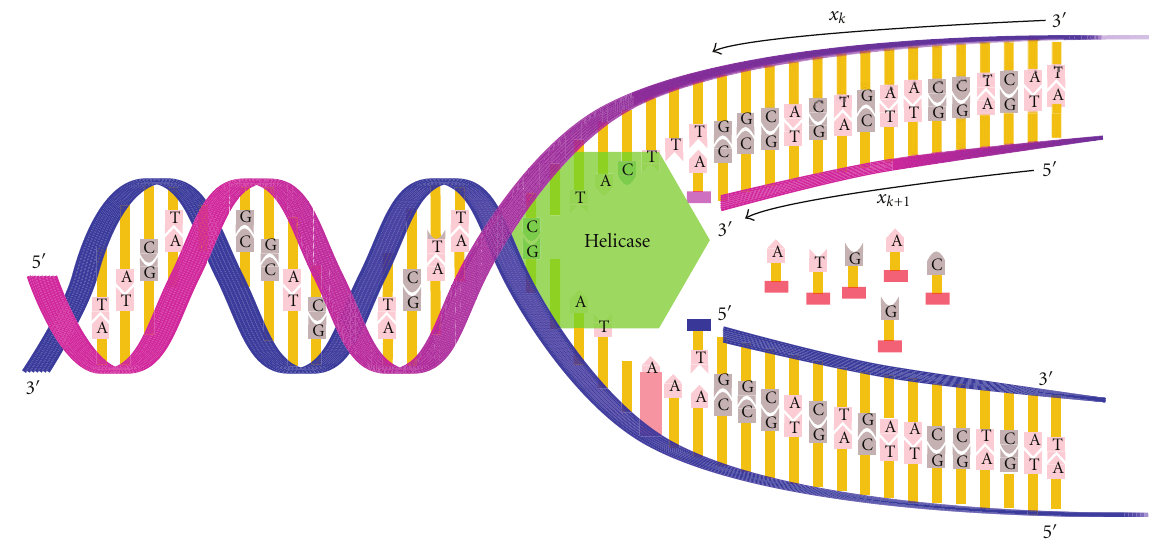
Figure 5: Biological information flow in central dogma of molecular biology.